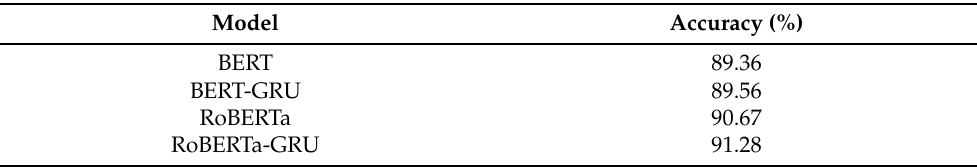
Table 6. The Comparison Results between BERT and